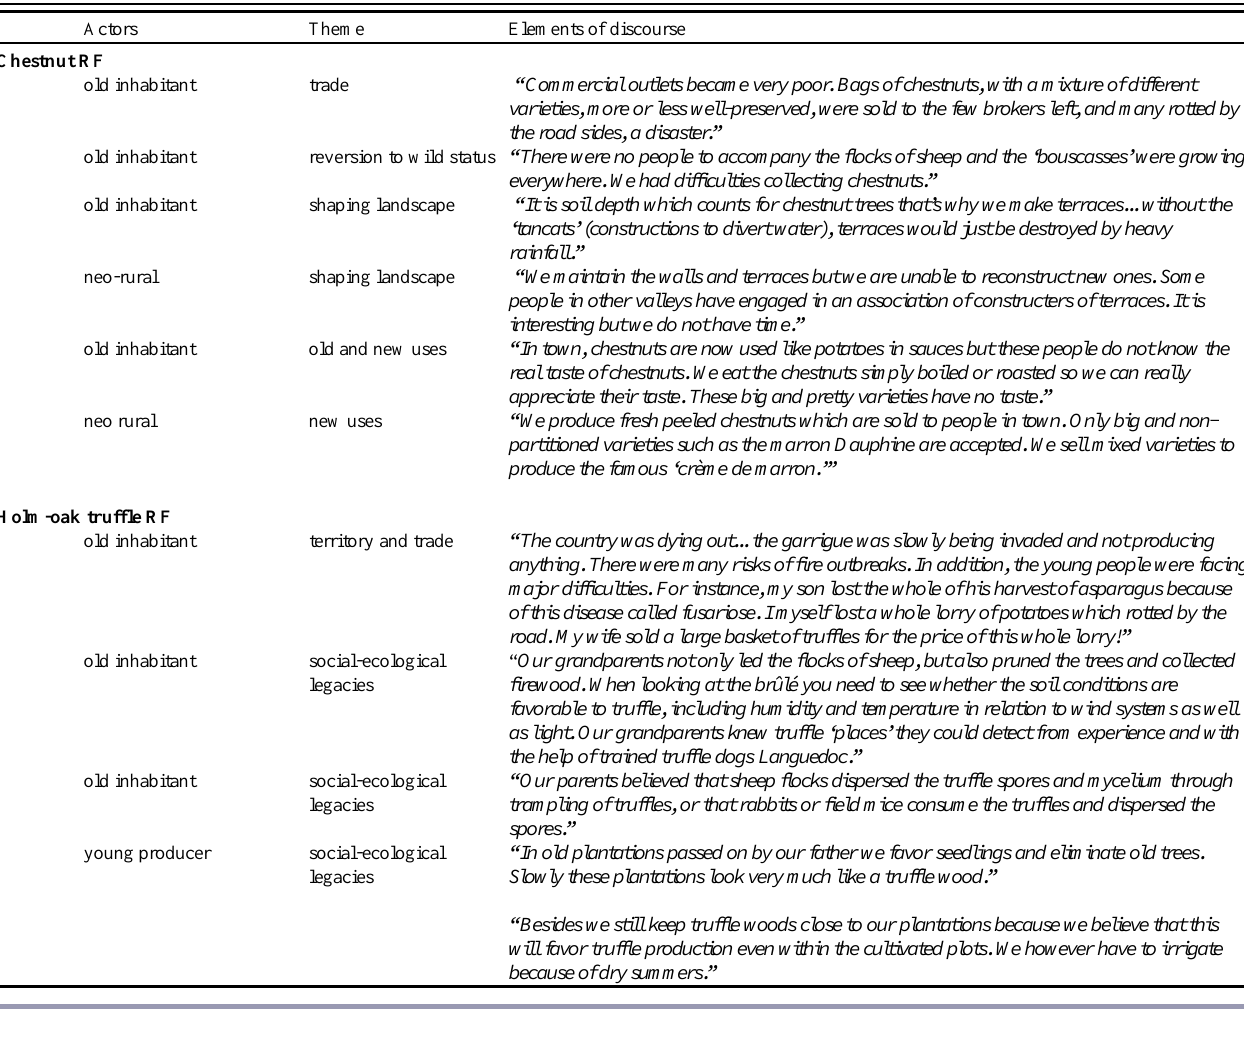
Table 2 . Elements of discourse illustrating different actors’ perceptions about the decline and renewal of chestnut ( Castanea sativa Mill.) and holm-oak ( Quercus ilex L.) rural forests